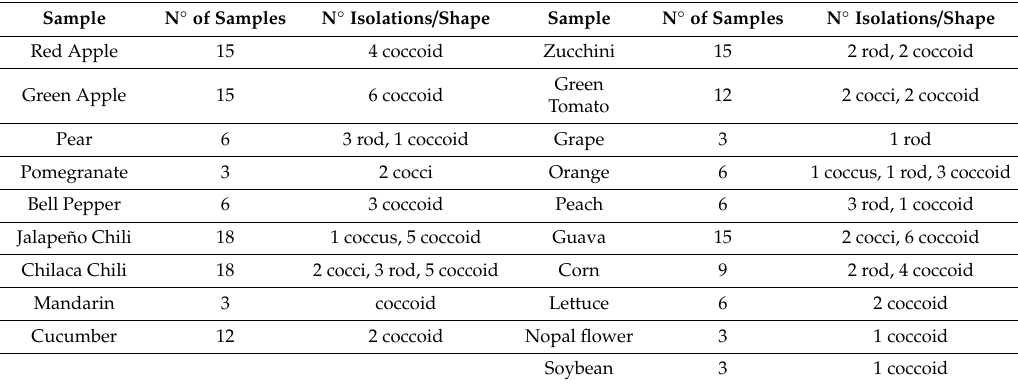
Table 2. Fruit and vegetable sampled and the number of lactic acid bacteria